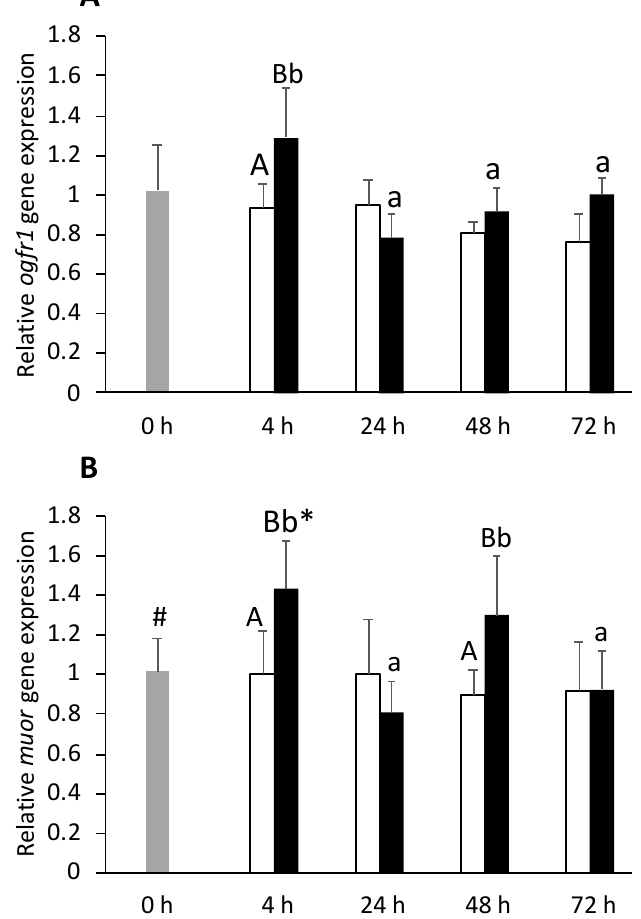
Figure 9. Telencephalic expression of opioid growth factor 1 ( ogfr1 , A ) and mu opioid receptors Figure 1. Telencephalic expression of serotonin receptors 2B ( htr2b , A ) and 2C ( htr2c , B ) in Figure 3. Optic tectum expression of serotonin receptor 2C ( htr2c , A ) and glucocorticoid receptor 2 undisturbed European seabass (0 h, ) or i.p.-injected with a sham solution (CTRL, □ ) or Freund’s ( muor , B ) in undisturbed European seabass (t0h, ) or i.p.-injected with a sham solution (CTRL, (cid:3) ) or ( gr2 , B ) in undisturbed European seabass (0 h, ) or i.p.-injected with a sham solution (CTRL, □ ) or Incomplete Adjuvant (FIA, ■ ) and sampled at 4, 24, 48, 72 h post-injection (means ± SD, n = 8). One- Freund’s Incomplete Adjuvant (FIA, ■ ) and sampled at 4, 24, 48, 72 h post-injection (means ± SD, n Freund’s Incomplete Adjuvant (FIA, ) and sampled at 4, 24, 48, 72 h post-injection (means ± SD, way ANOVA was performed to identify differences between i.p.-injected fish and the undisturbed = 8). Different symbols (* and #) stand for significant differences between i.p.-injected groups and n = 8). Different symbols (* and #) stand for significant differences between i.p.-injected groups group, followed by a Tukey post-hoc test. Different symbols (*,#) stand for significant differences the undisturbed group (0 h). Capital letters stand for significant differences between stimuli. Lower- and the undisturbed group (0 h). Capital letters stand for significant differences between stimuli. between i.p.-injected groups and the undisturbed group (0 h). Two-way ANOVA was performed to case letters indicate significant differences between sampling times. Further details in legend of Lower-case letters indicate significant differences between sampling times. Further details in legend identify significant differences within the i.p.-injected fish, followed by a Tukey post-hoc test. Figure 1. of Figure Capital letters stand for significant differences between stimuli. Lower-case letters indicate signifi- cant differences between sampling times ( p ≤ 0.05).